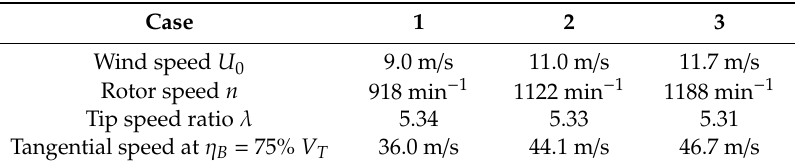
Table 3. Test conditions